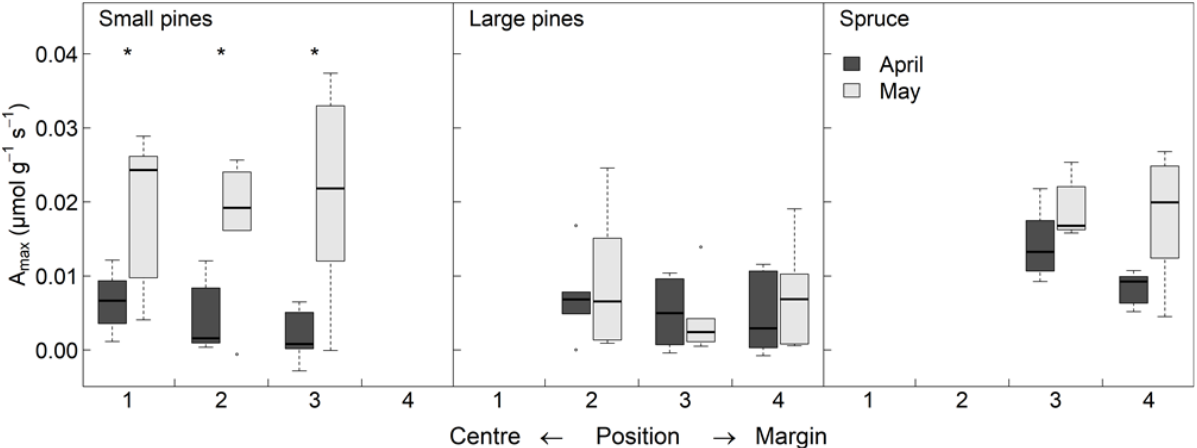
Figure 5. Maximum photosynthetic capacity ( A max ) in Pinus rotundata (Small and Large pines) and Picea abies (Spruce) in April and May 2014. Asterisks indicate significant differences between the April and May measurement periods. No significant differences were observed between the positions along the two transects.